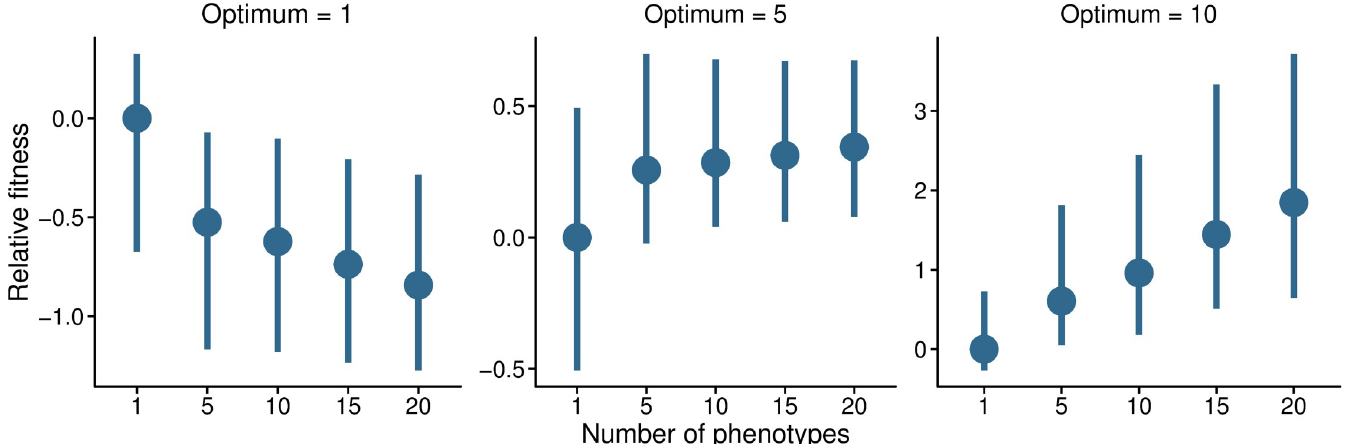
Fig 5. Simulated population fitness under different levels of pleiotropy, i.e. the number of phenotypes controlled by a single QTL (horizontal axis). Phenotypes start from an initial value 0 and selection acts to move them towards three different optima. Shown are medians and interquartile ranges (IQR) from 300 simulation. The fitness estimates were normalized in relation to the non-pleiotropic class (median = 0, IQR = 1).